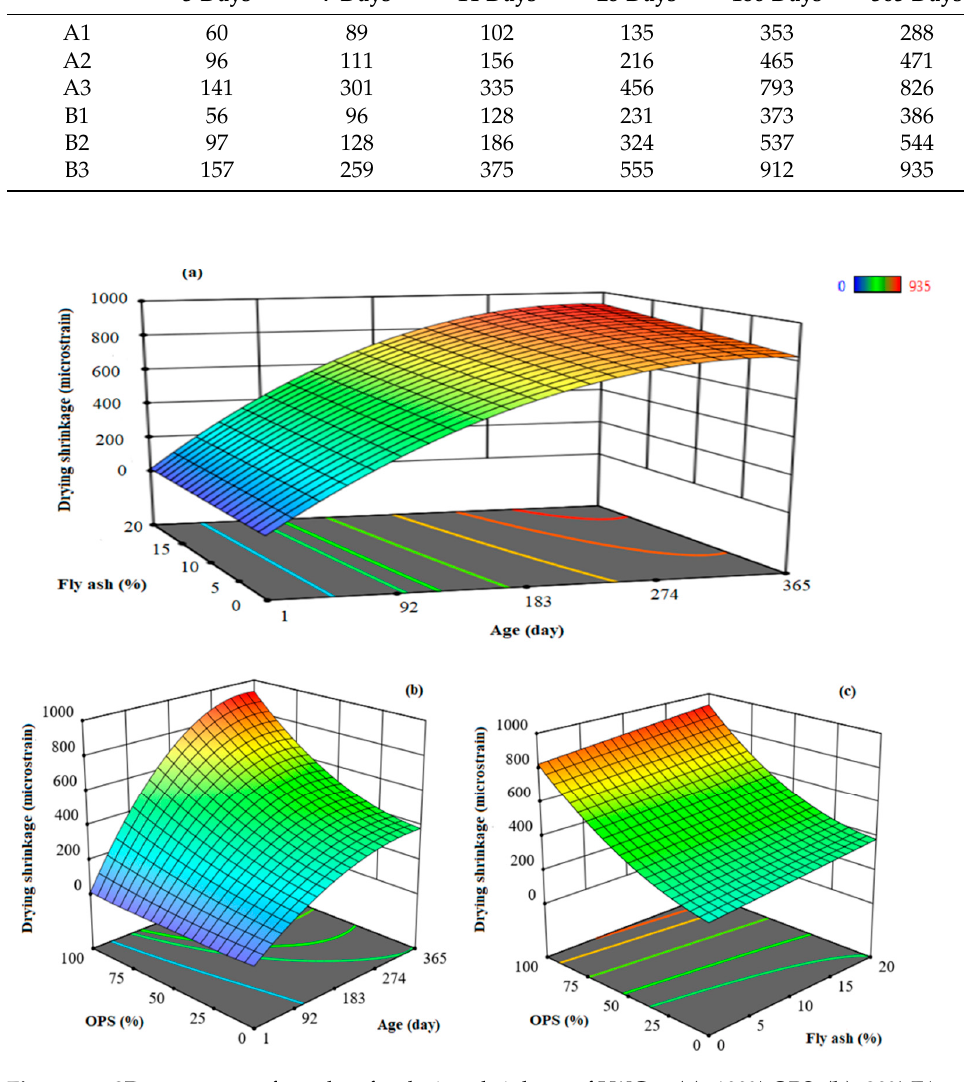
Figure 11. 3D response surface plots for drying shrinkage of LWC at ( a ): 100% OPS, ( b ): 20% FA, and ( c ): age of 365 days under 7-day water curing.